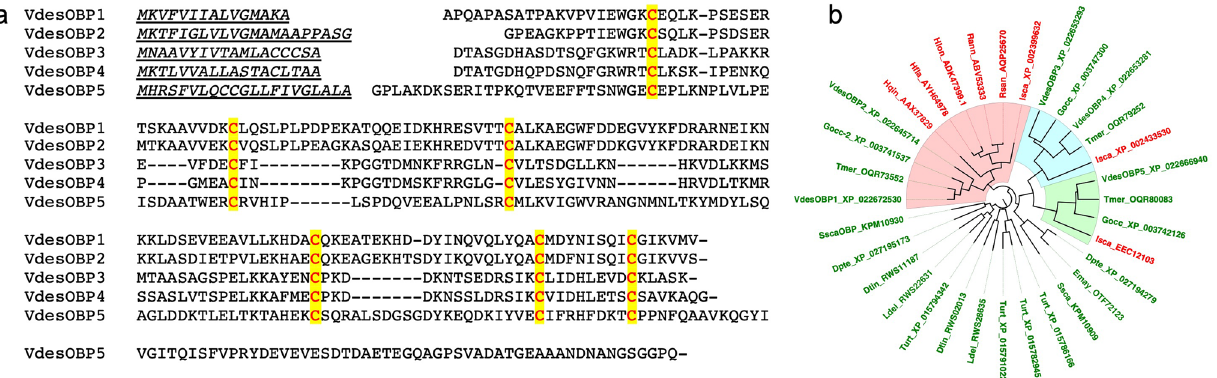
Figure 1. ( a ) Alignment of the five OBPs of V. destructor . The six conserved cysteines are highlighted. VdesOBP1 and VdesOBP2 are very similar (72% identity), as VdesOBP3 and VdesOBP4 (60%), but proteins of the two groups share only about 15% of their residues between them as well as with VdesOBP5. The six conserved cysteines are highlighted and in red font. Signal peptides are underlined. ( b ) Phylogenetic tree of tick and mite OBPs. Vdes: Varroa destructor ; Turt: Tetranychus urticae ; Hqin: Haemaphysalis qinghaiensis ; Hfla: Haemaphysalis flava ; Hlon: Haemaphysalis longicornis ; Isca: Ixodes scapularis ; Gocc: Galendromus occidentalis ; Tmer: Tropilaelaps mercedesae ; Rann: Rhipicephalus annulatus ; Rsan: Rhipicephalus sanguineus ; Ldel: Leptotrombidium delicense ; Dtin: Dinothrombium tinctorium ; Dpte: Dermatophagoides pteronyssinus ; Ssca: Sarcoptes scabiei ; Emay: Euroglyphus maynei . All sequences used to build the tree are reported in Supplementary Table S1 online. Names of ticks are in red, those of mites are in green. Highlighted clades contain VdesOBP1 and VdesOBP2 (pink), VdesOBP3 and VdesOBP4 (light blue), VdesOBP5 (light